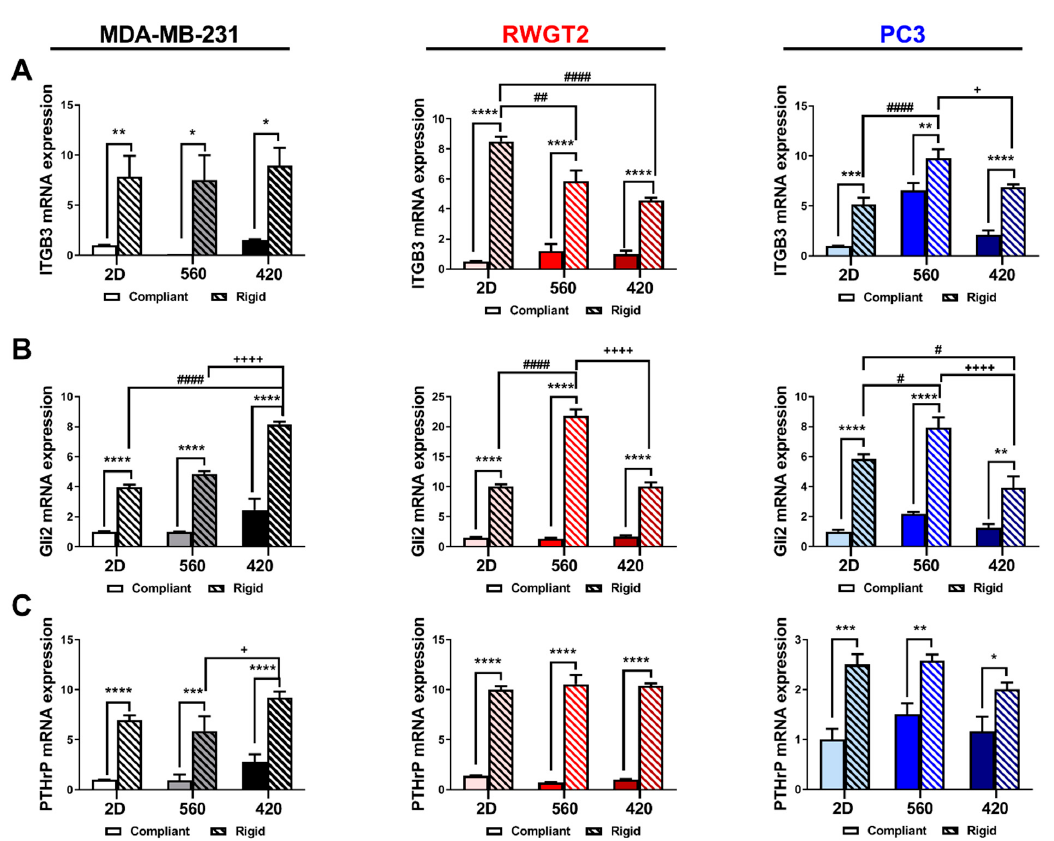
Figure 3. Effects of substrate modulus and pore size on gene expression of bone-metastatic tumor cells. The breast cancer cell line, MDA-MB-231 (black), the lung cancer cell line, RWGT2 (red), and the prostate cancer cell line, PC3 (blue), were seeded on 2D films or 3D scaffolds, cultured for 48 h and analyzed for changes in gene expression. Expression of ( A ) ITGB3, ( B ) Gli2, and ( C ) PTHrP were significantly increased for all cell types analyzed with respect to changes in both pore size and rigidity. Data presented as fold change over 2D compliant. Two-way ANOVA. Compliant vs. rigid, * p < 0.05, ** p < 0.01, *** p < 0.001, **** p < 0.0001. 560 vs. 420, + p < 0.05, ++++ p < 0.0001. 2D vs. 3D, # p <